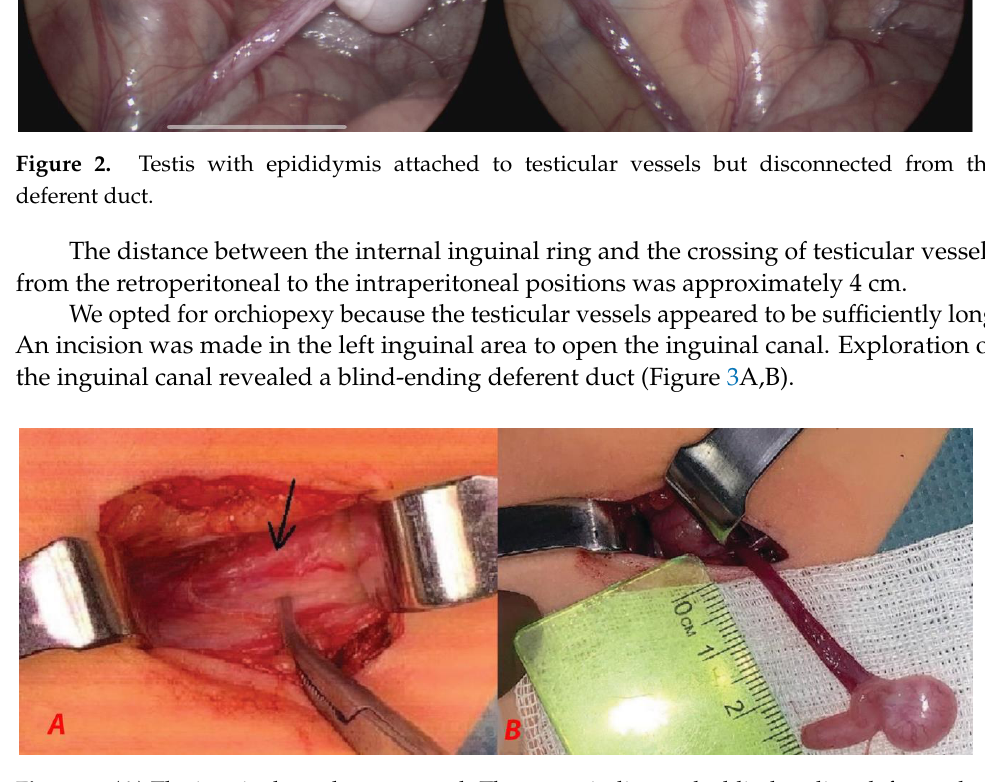
Figure 4. The left testis was fixed in the upper scrotum. Patient 2, aged 48 months, underwent diagnostic laparoscopy for a nonpalpable left- sided testis. Laparoscopy revealed an intra-abdominal testis and epididymis attached to the testicular vessels. The testis and epididymis were completely separated from the def- erent duct. The distance between the internal inguinal ring and the crossing of testicular vessels from the retroperitoneal space to the intraperitoneal position was 4 mm to 5 mm, and the processus vaginalis was patent (Figure 5).